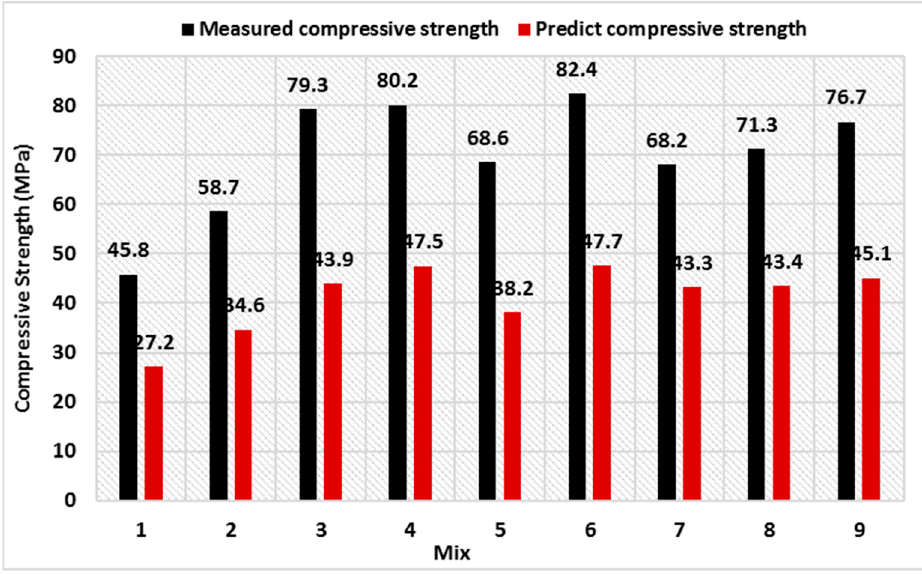
Figure 9. Measured versus predicted compressive strengths using Schmidt hammer test results.